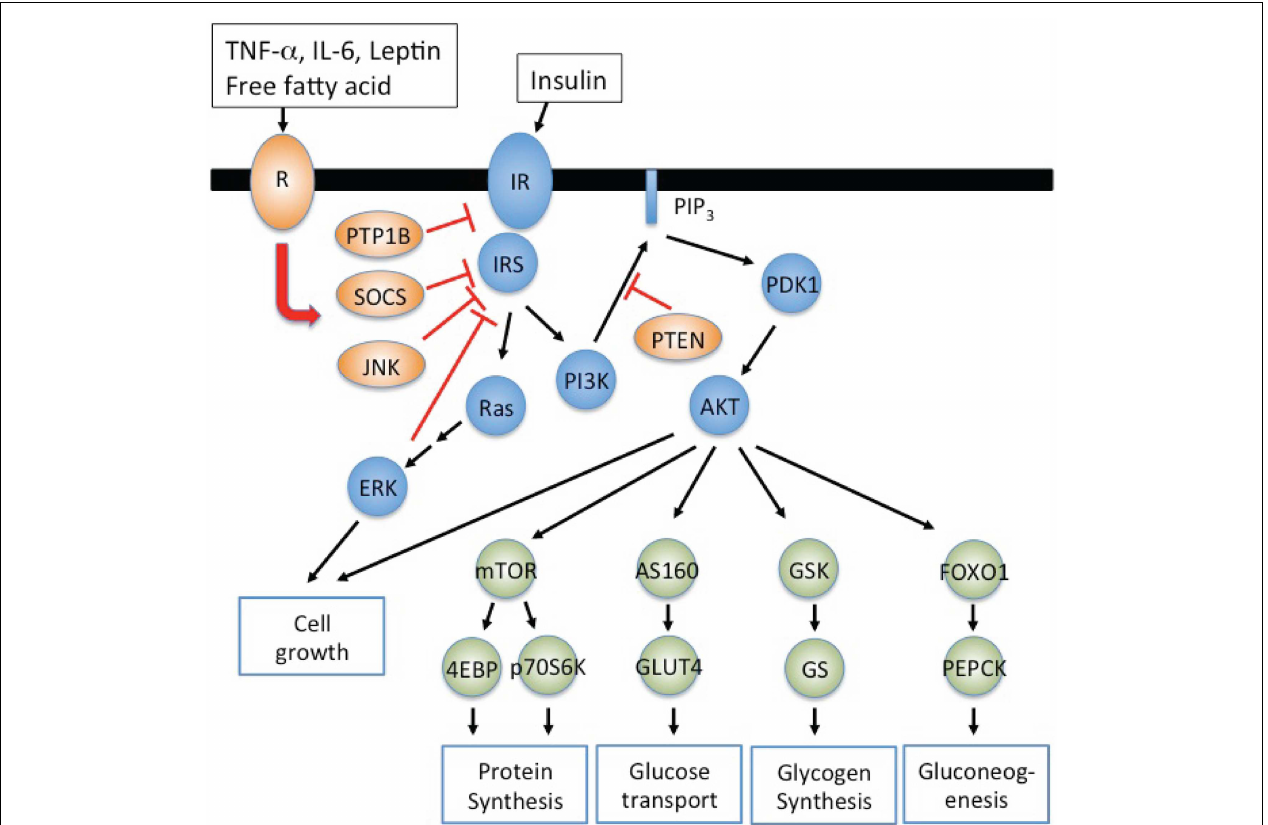
protein synthesis (muscle and liver), and gluconeogenesis (liver). Inflammatory signals,TNF- α , IL-6, LPS, and saturated free fatty acid, activate inhibitory molecules such as SOCS and JNK to suppress insulin signaling resulting in insulin resistance. PI3K dependent PDK1 activation is negatively regulated by phospholipid phosphatases such as phosphatase and tensin homolog (PTEN) that degrade PIP 3